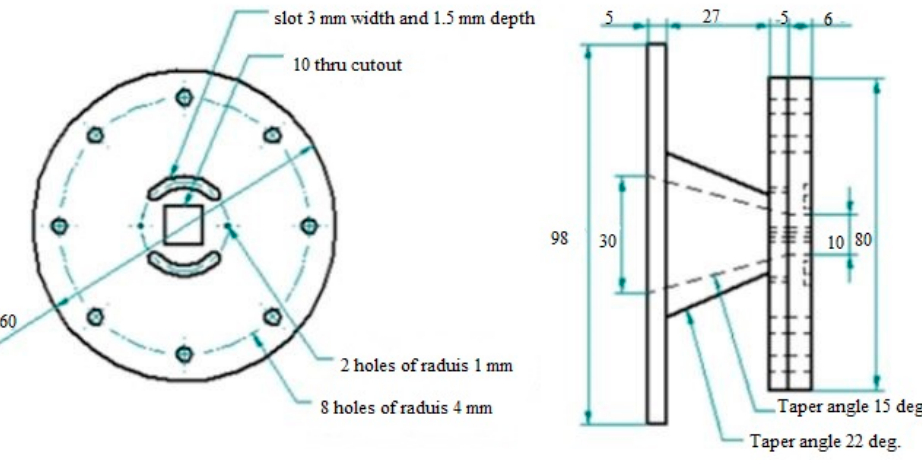
Figure 7. Square nozzle and grooved control plate [7].